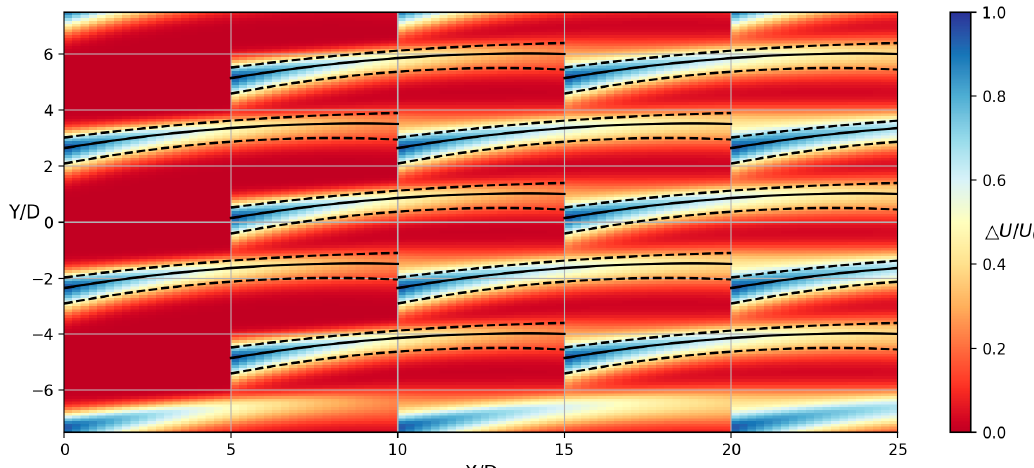
Figure 8. The velocity contour of the array, which is the optimal arrangement under the criterion of average inflow velocity. y 1 = 5, x 2 = 5, y 2 = 2.5. The color bar is the velocity deficit, the black solid lines represent the position of the maximum velocity deficit, and the black dashed lines represent the deviations of the double semi Gaussian functions.